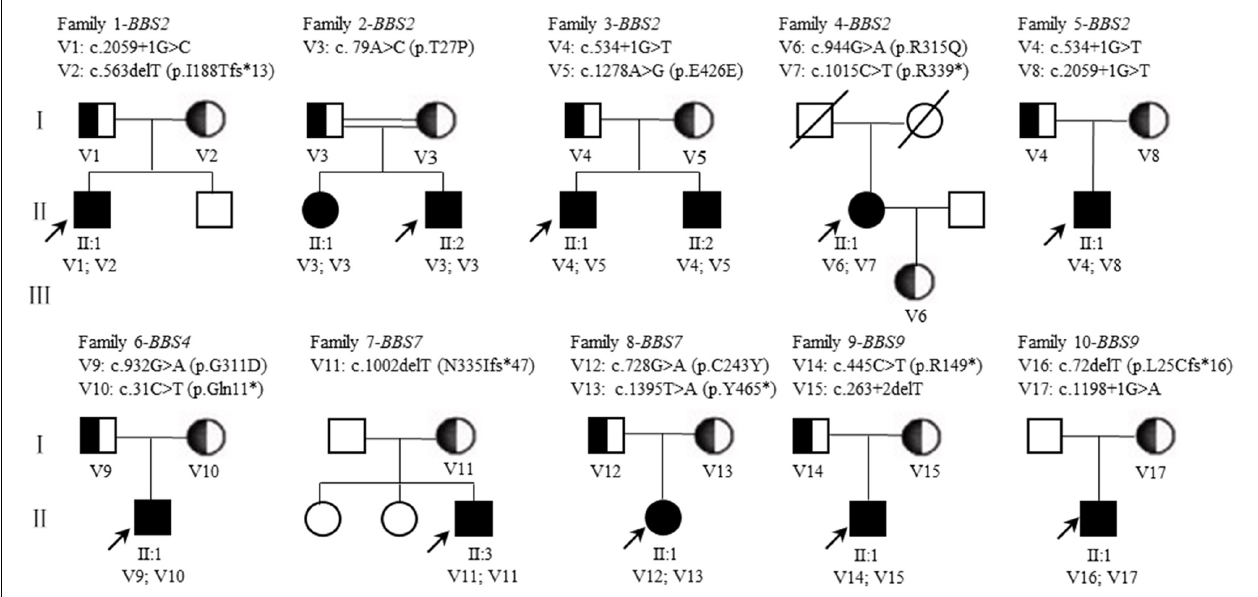
FIGURE 4 | Pedigrees of BBS families. The squares and circles indicate men and women, respectively. The black solid square or circle represent the affected individual. The half black solid circle or square represent variation carrier. The probands are indicated by arrows. V, variant. A double line indicates a consanguineous marriage (The parents of F2-II:1 and F2-II:2 are consanguineous). A diagonal indicates that the individual has died.